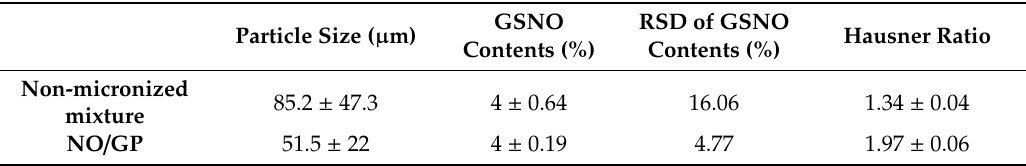
Table 1. Content homogeneity and flowability of in situ hydrogel-forming / nitric oxide (NO)-releasing powder dressing (NO /